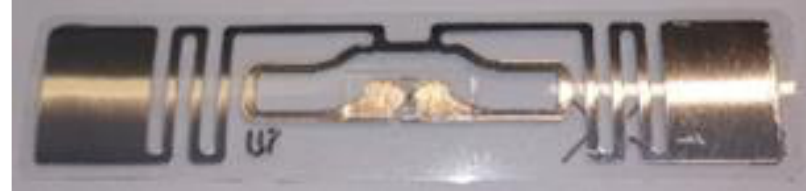
Figure 3. Partially extracted RFID identifier sample.